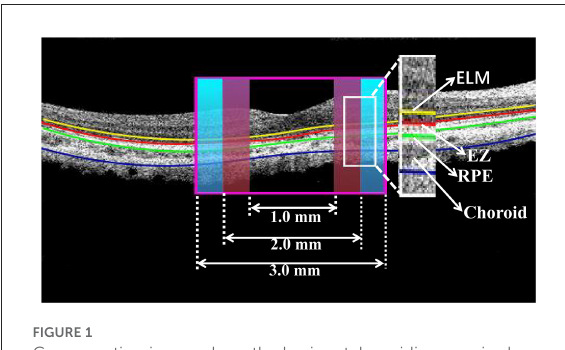
FIGURE1 Cross-section image along the horizontal meridian acquired from OCT. The boundaries of fundus structure were segmented, and the appearance of EZ and RPE were obtained in the foveal region with a diameter of 1mm and the parafoveal region ranging from 1 to 3mm from the foveal region.